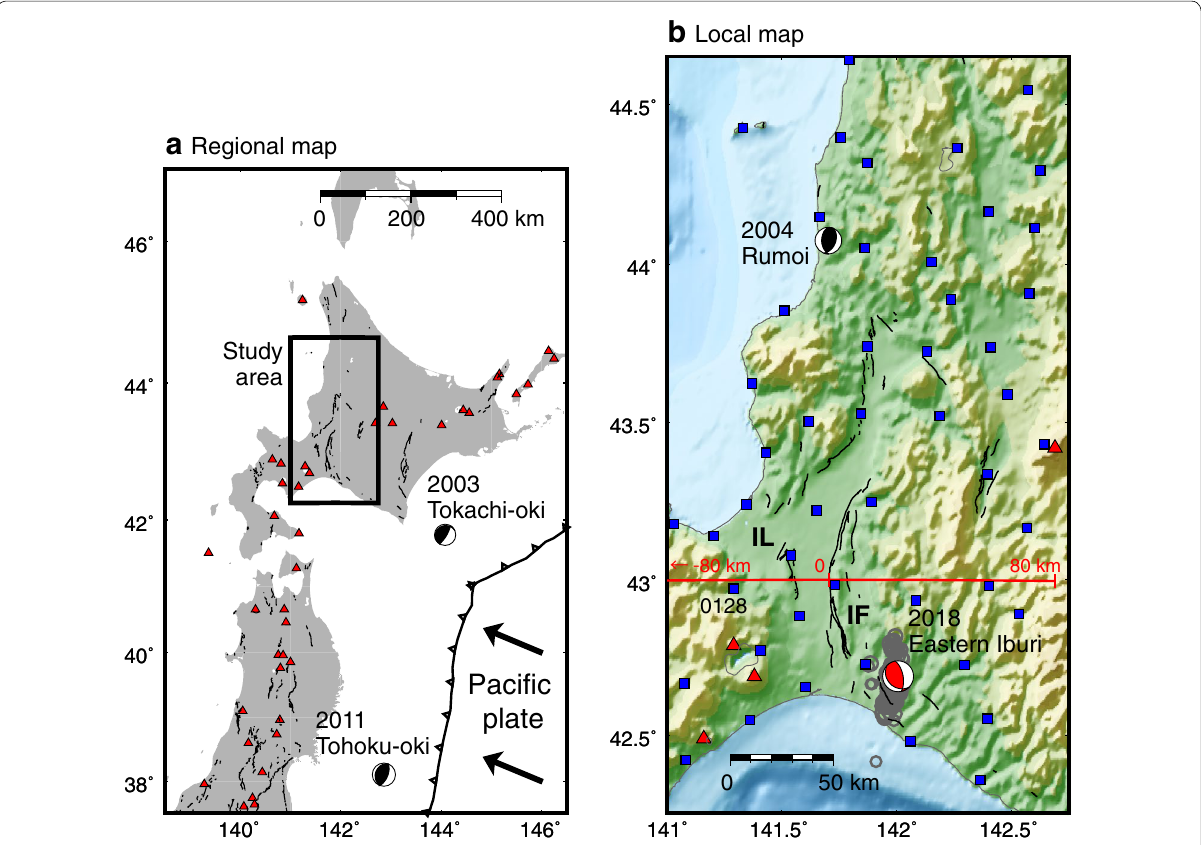
Fig. 1 a Regional map of the study area. The black solid line and red triangle indicate active faults (Nakata and Imaizumi 2002) and volcanos, respectively. Focal mechanisms are located at the epicenter of the 2003 Tokachi-oki and 2011 Tohoku earthquakes (F-net solution, NIED 2018). The vectors indicate Pacific plate motion with respect to Okhotsk plate (~ 85 mm/year). b Location of GNSS sites and seismicity associated with the 2018 Iburi earthquake and aftershocks. The mainshock is shown with a red focal mechanism. Background seismicity, denoted by grey circles, are aftershocks over Mj 3.0 during the ten measured for 10 days following the mainshock. Aberrations of IF and IL are the Ishikari fault zone and = Ishikari lowlands, respectively. GNSS site 0128 (Sapporo) is the fixed site used for horizontal velocity estimations. The location and focal mechanism of the 2004 Rumoi earthquake (F-net solution) are also plotted. The red line shows the strain profile used for Fig.